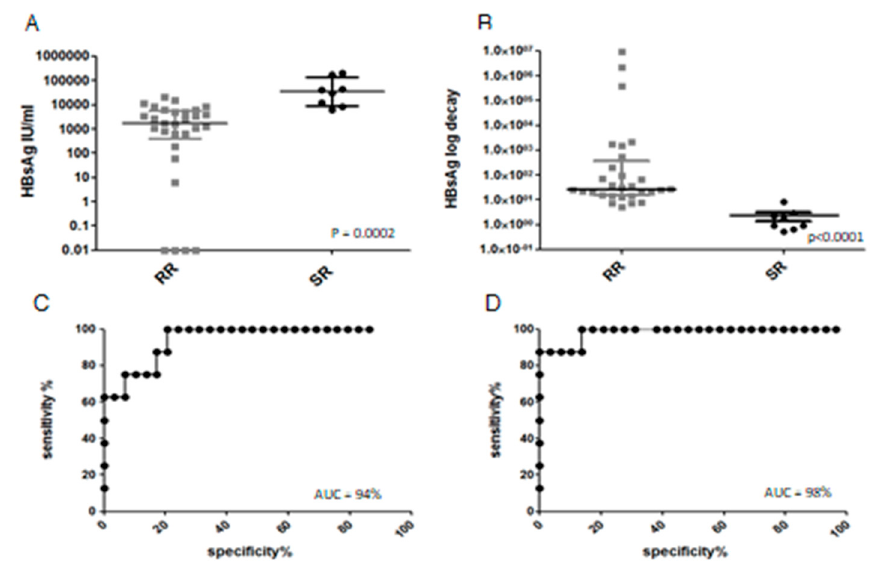
Figure 3. Comparison of HBsAg values and their decay kinetics in RR and SR patients. Absolute HBsAg values on day 28 (HBsAg d28 ) from admission ( A ) and HBsAg decay slopes (expressed as difference in log HBsAg concentration between day 0 and day 28: HBsAg decay d0–28 ) ( B ). Medians with interquartile ranges are shown as horizontal lines. Receive Opeator Corve (ROC) curve for HBsAg d28 as predictor of chronification ( C ). ROC curve for log HBsAg decay d0–28 as predictor of chronification ( D ). AUC: Area Under the Curve.